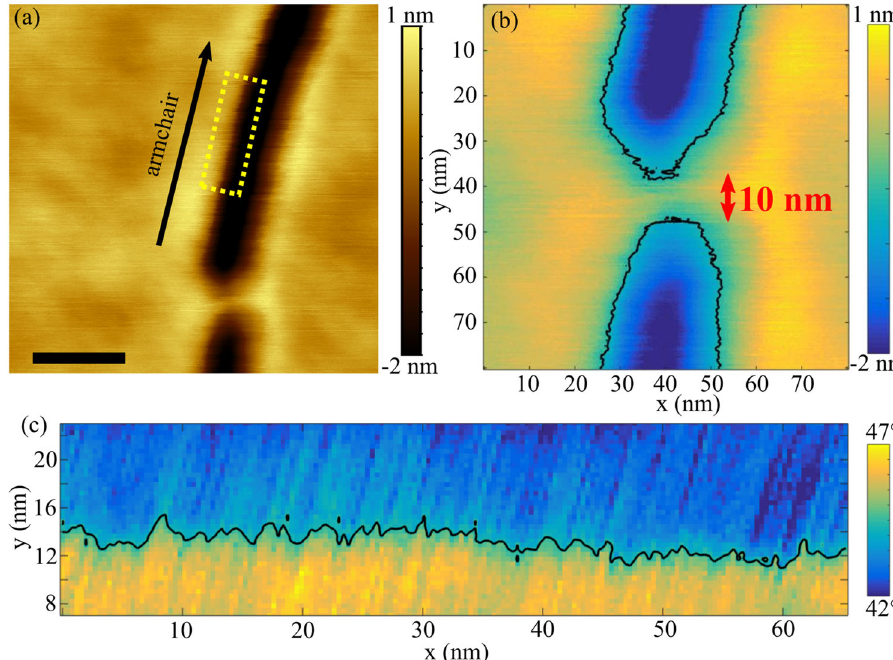
Fig. 2 High resolution AFM cleavage lithography of graphene quantum point contacts. a Topographic tapping-mode AFM image of a 10 nm wide graphene constriction. Scale bar: 500 nm. b Locating the graphene edges. c Estimating the edge roughness from the phase image of the dashed rectangular area of Fig. 2a: The black line marks the border of the step-like deviation from the average phase value on